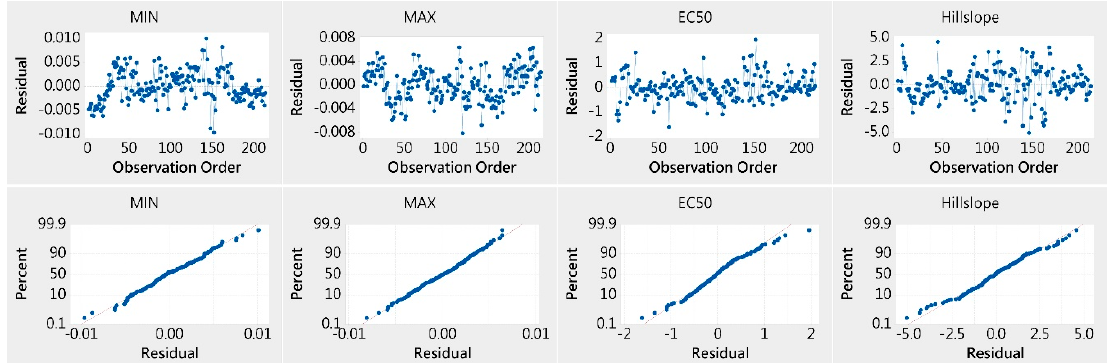
Figure 6. A diagnosis of outliers and the appropriateness for derived parameters of the logistic primary signal model using residual vs. observation order (upper) and normal probability plot of residual (lower) in each subfigure of the modelling with ( a )/without ( b ) outliers. An additional set of tree crown spectral data ( n = 92) was used to validate the performance of the GLGCM technique in the restoration of field based data. The contaminated signals of such validation spectra as shown in Figure 7a mostly ranged from 0.0 to 0.6 in which the amount of noise removed by the GLGCM method varied between − 0.2 and 0.4. Based on an identical scale of wavelength in the SWIR can be visually interpreted via Figure 7b,c. For such cases of field measured The RMSE of the GLGCM was evaluated based on the biases occurring at the specific point of the front ‐ edge base and end ‐ edge base. The RMSE of the two segments averaged 0.0031 ± 0.0003 and